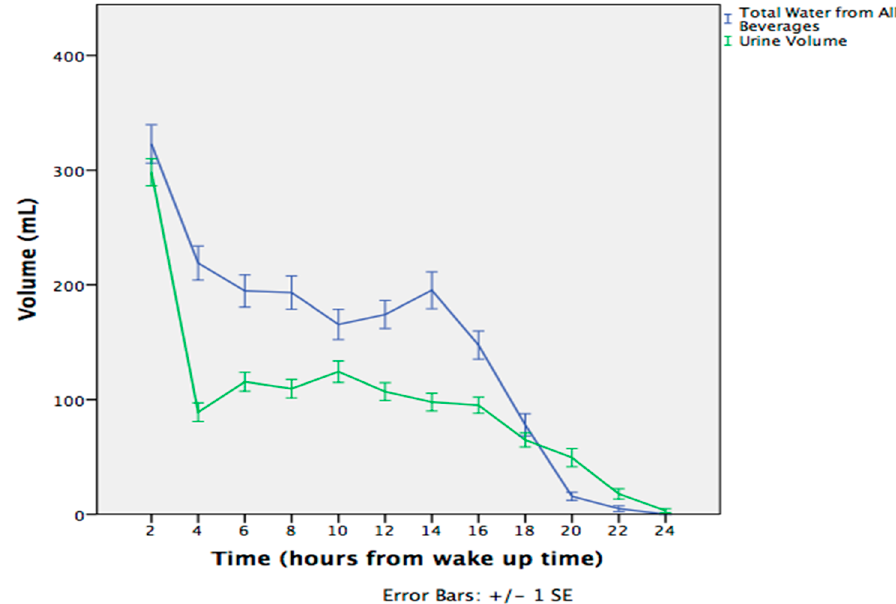
Figure 1. Volume of total water intake from all beverages and of urine excretion during the day.